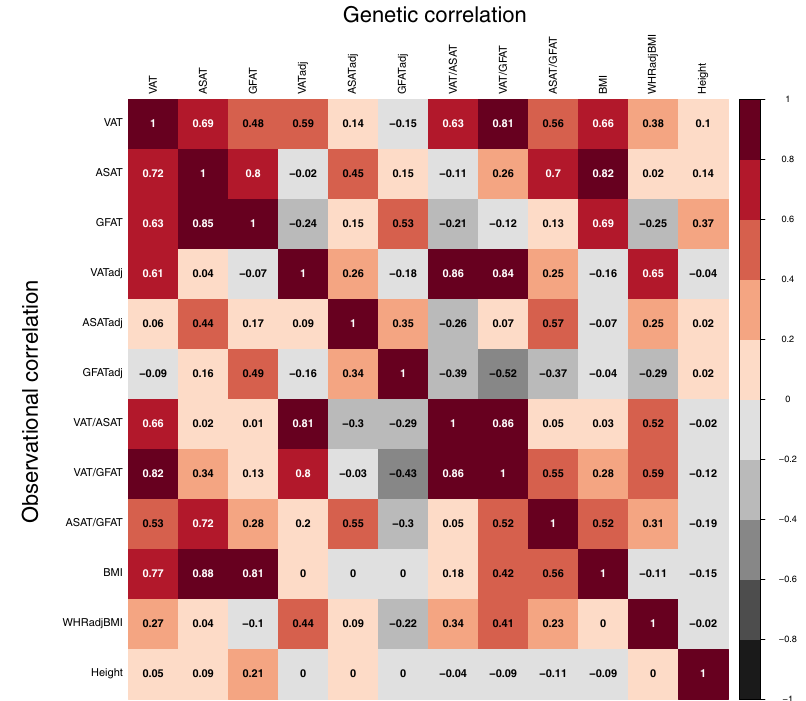
Fig. 2 Observational and genetic correlations between MRI-derived adiposity traits, BMI, and WHRadjBMI. Observational correlations displayed are Pearson correlation coef fi cients. Genetic correlations were obtained from cross-trait LD-score regression using sex-combined summary statistics. Additional correlogram entries, including sex-strati fi ed analyses, are available in Supplementary Figs. 6 and